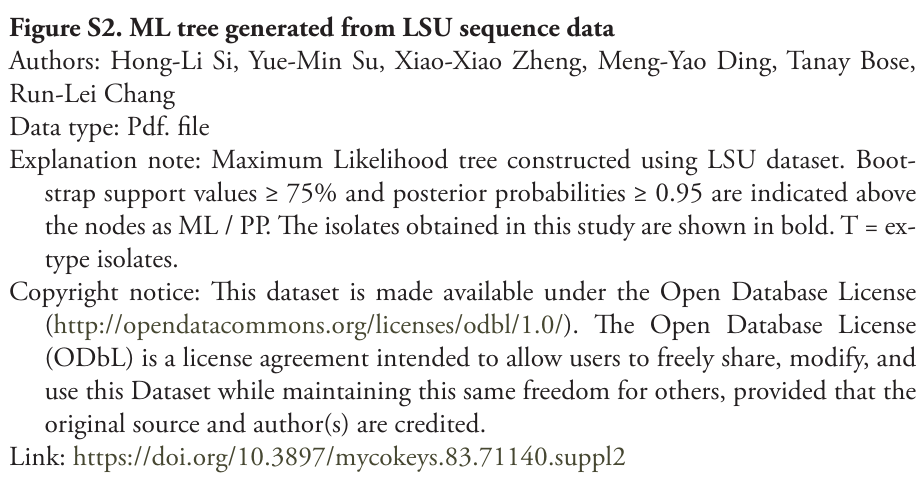
Figure S2. ML tree generated from LSU sequence